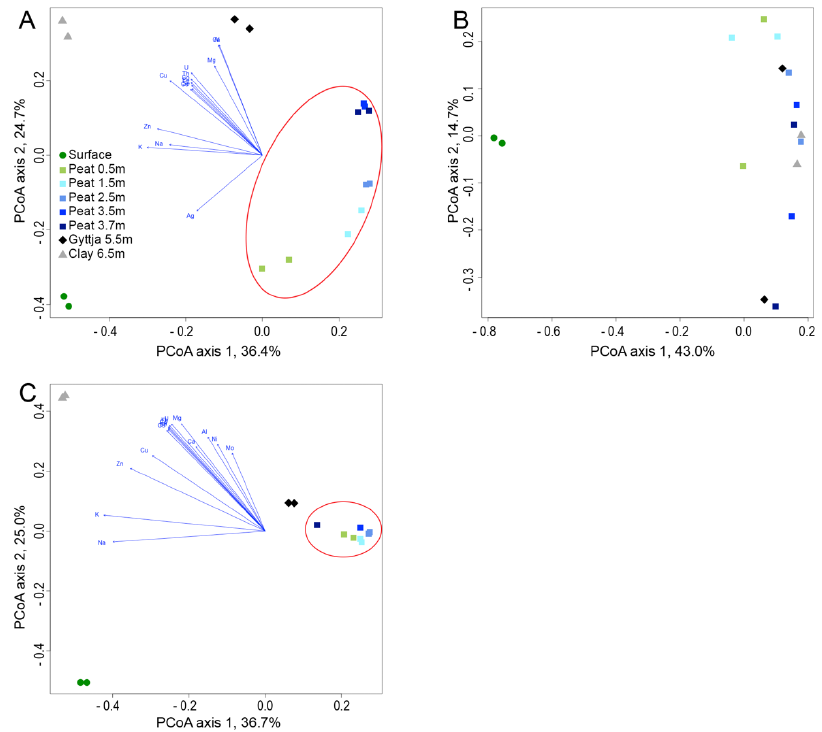
Figure 6. Principal Coordinates Analysis (PCoA) of the ( A ) archaeal, ( B ) fungal, and ( C ) bacterial communities in relation to environmental parameters. Vectors for metal concentrations having statistically significant ( p < 0.05) effect on the mi- crobial communities are shown. For fungi, no significant metal concentrations were identified. In A and C , the peat sam- ples are indicated with a red oval. No statistically significant correlation between bacterial numbers or microbial taxa and the concentration of Ni or Ag, or sorption of Ni and Ag in the tested samples, was